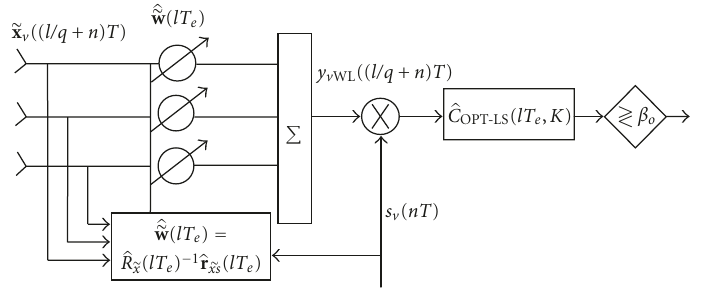
Figure 1: Functional scheme of the OPT-LS receiver.